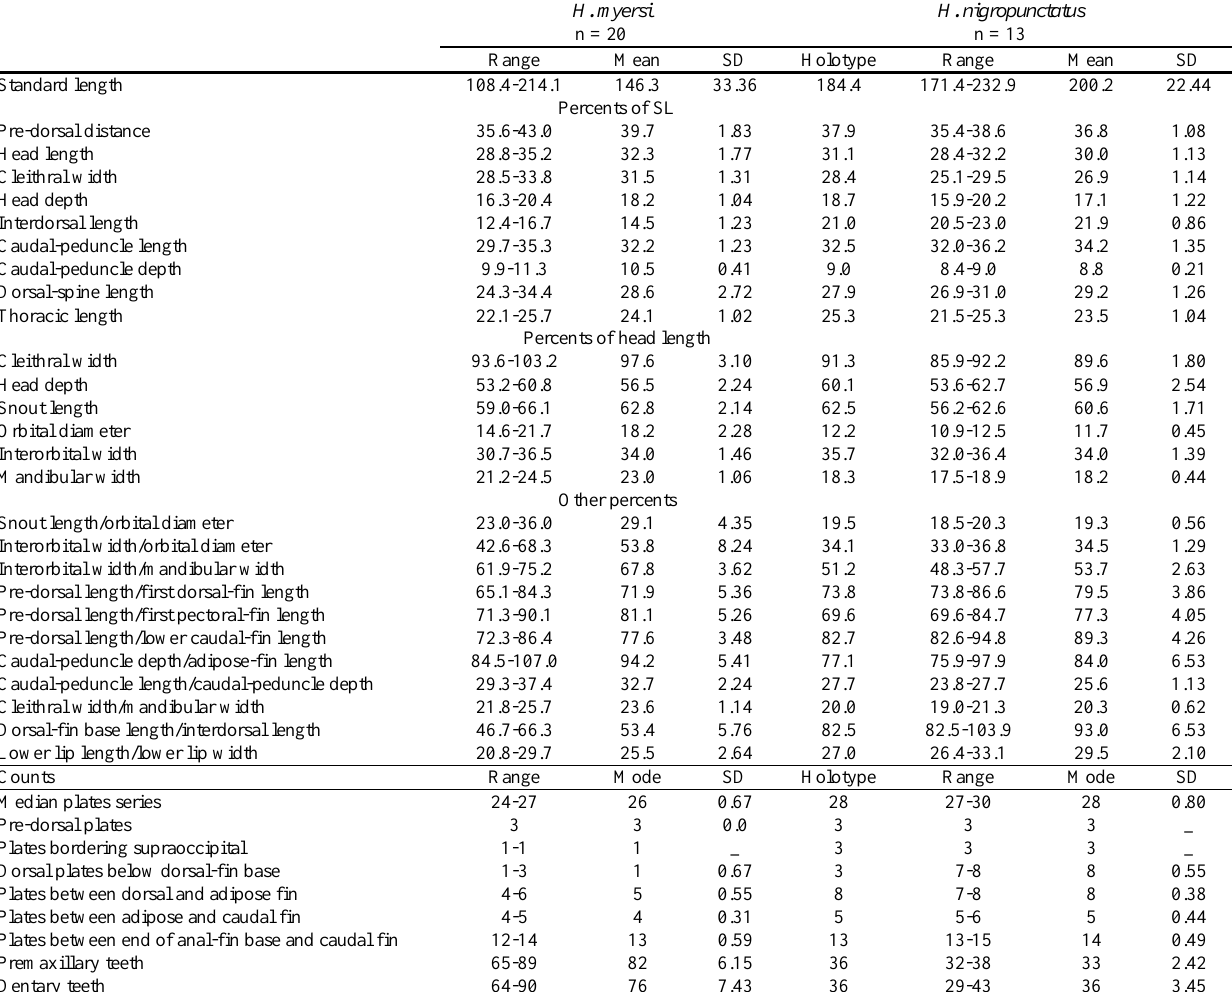
Table 2. Morphometric data and counts of Hypostomus myersi and H. nigropunctatus n. sp. from the rio Iguaçu basin, Brazil. SD = standard